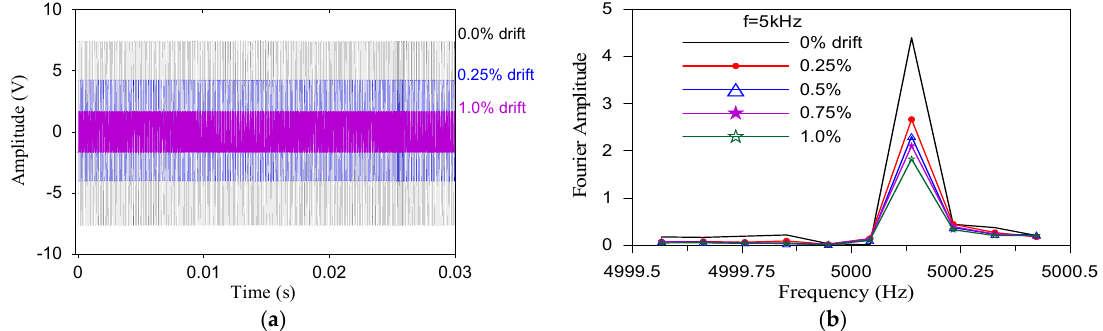
Figure 14. ( a ) Time history of received sensor voltage and ( b ) corresponding Fourier amplitude of sensor S4 for excitation frequency 5 kHz.